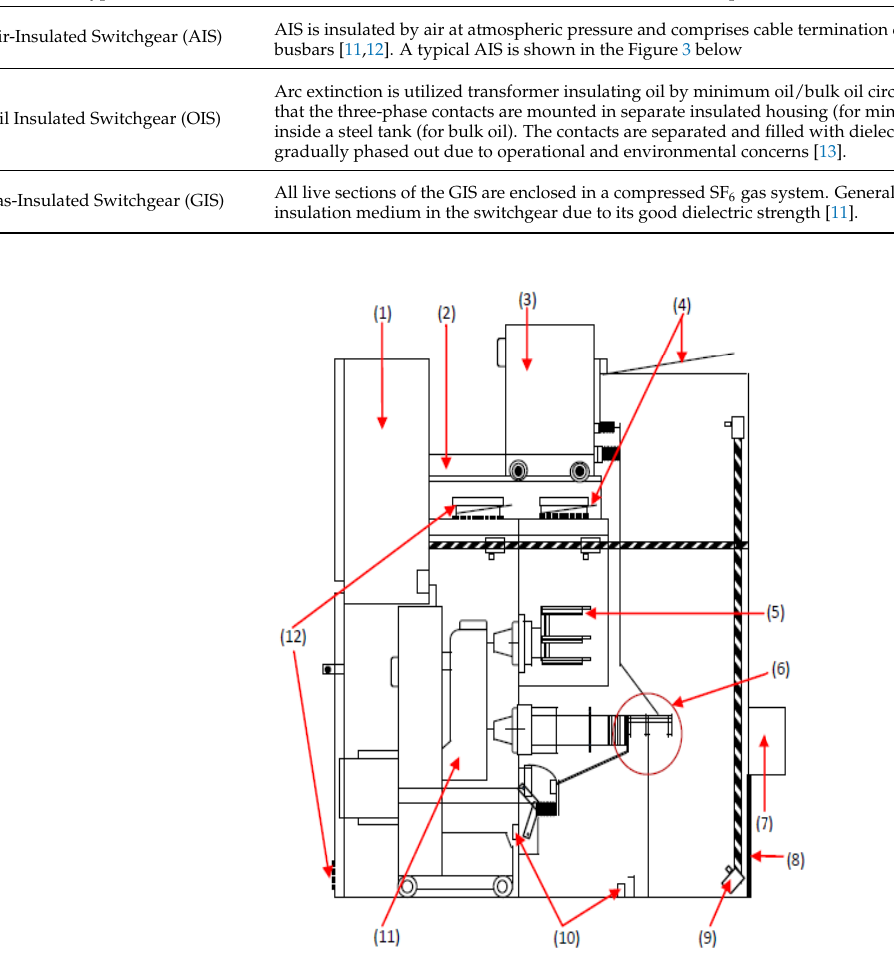
Figure 3. Side View of AIS Switchgear. 1. Metering Compartment. 2. Railing. 3. Draw out VT Truck. 4. Pressure Relief Flap. 5. Busbar. 6. Cable Termination. 7. Multi Core Cable Box. 8. Earth Bar. 9. Arc Protection. 10. Heater. 11. Vacuum Circuit Breaker. 12. Air Filter.